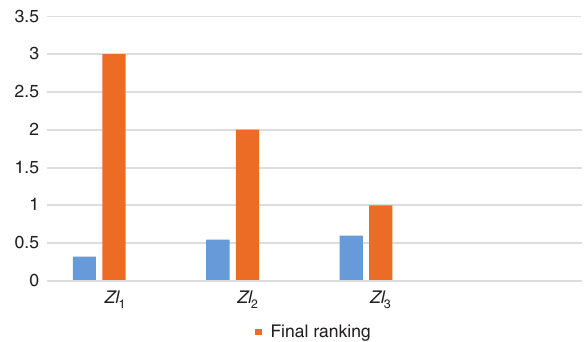
Figure 1: Final Ranking in Table